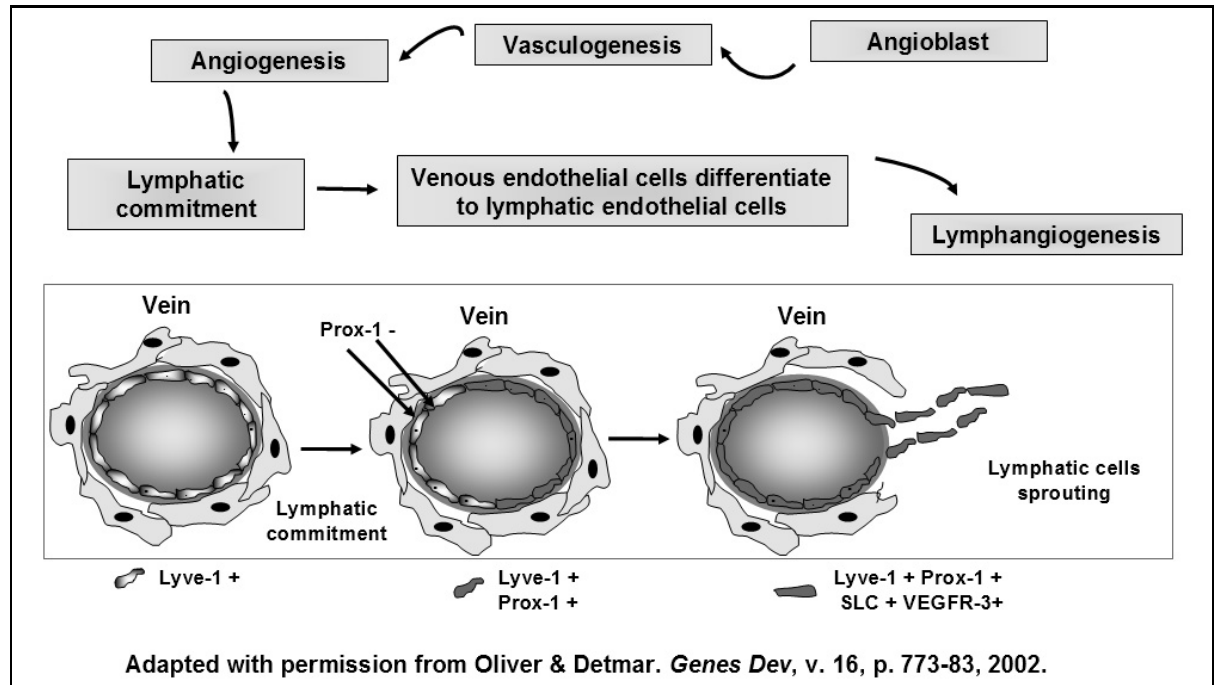
Figure 1 – Simplified representation of embryonic human lymphatic vessel differentiation. After the blood vessel net formation, endothelial lymphatic commitment occurs and the lymphatic conduits are